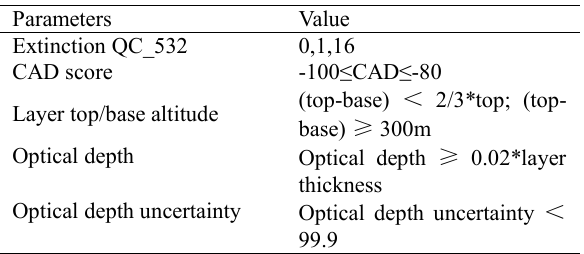
Table 1. Aloft aerosol layer data quality control